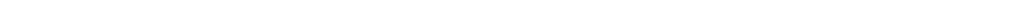
Figure 1: Up-titration roadmap for patients with HFrEF . ACEI = angiotensin-converting-enzyme inhibitor; AE = adverse event; AHA = American Heart Association; ARB = angiotensin receptor blocker; ARNI = angiotensin receptor-neprilysin inhibitor; BB = beta blockers; ESC = European Society of Cardiology; GP = General Practitioner; HFrEF = heart failure (HF) with reduced ejection fraction; MRA = mineralocorti- coid receptor antagonist; PCP = primary care physician. Based on the scientific content of the publications from Hickey 2016 [45] with data from Ponikowski et al. 2016 [1], Yancy 2013/2017 [47, 48] and the Canadian Cardiovascular Society 2017